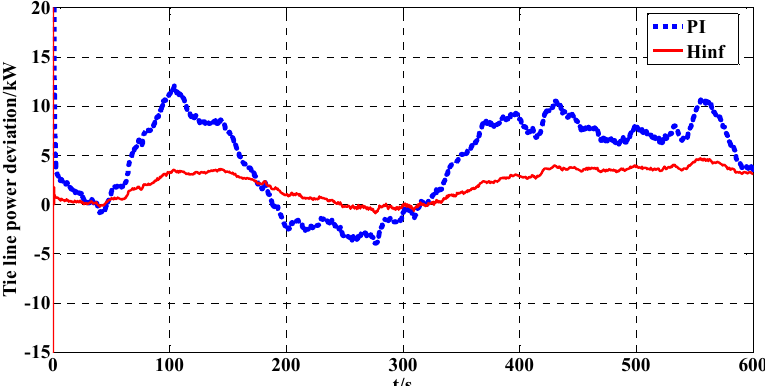
Figure 10. Tie-line power curves for case C under PI and proposed control strategies.